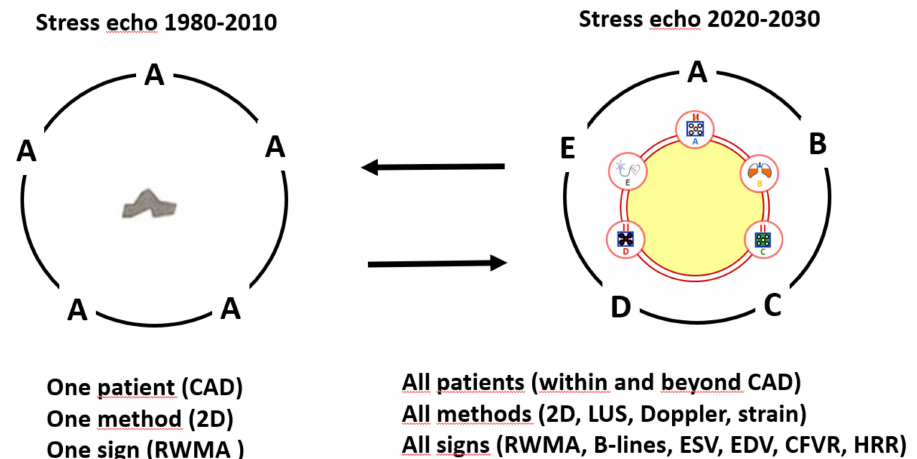
Figure 1. The conceptual approach of advanced stress echocardiography (SE): from vulnerable stenosis to vulnerable patient. Left panel: in the classical or conventional approach that has been used for 40 years and in first-generation multicenter studies such as Echo-Persantine Cooperative (EPIC) and Echo-Dobutamine Cooperative (EDIC) studies, SE was only focused on the hemodynamic significance of the coronary stenosis. Right panel: the advanced ABCDE protocol used in the last 5 years in